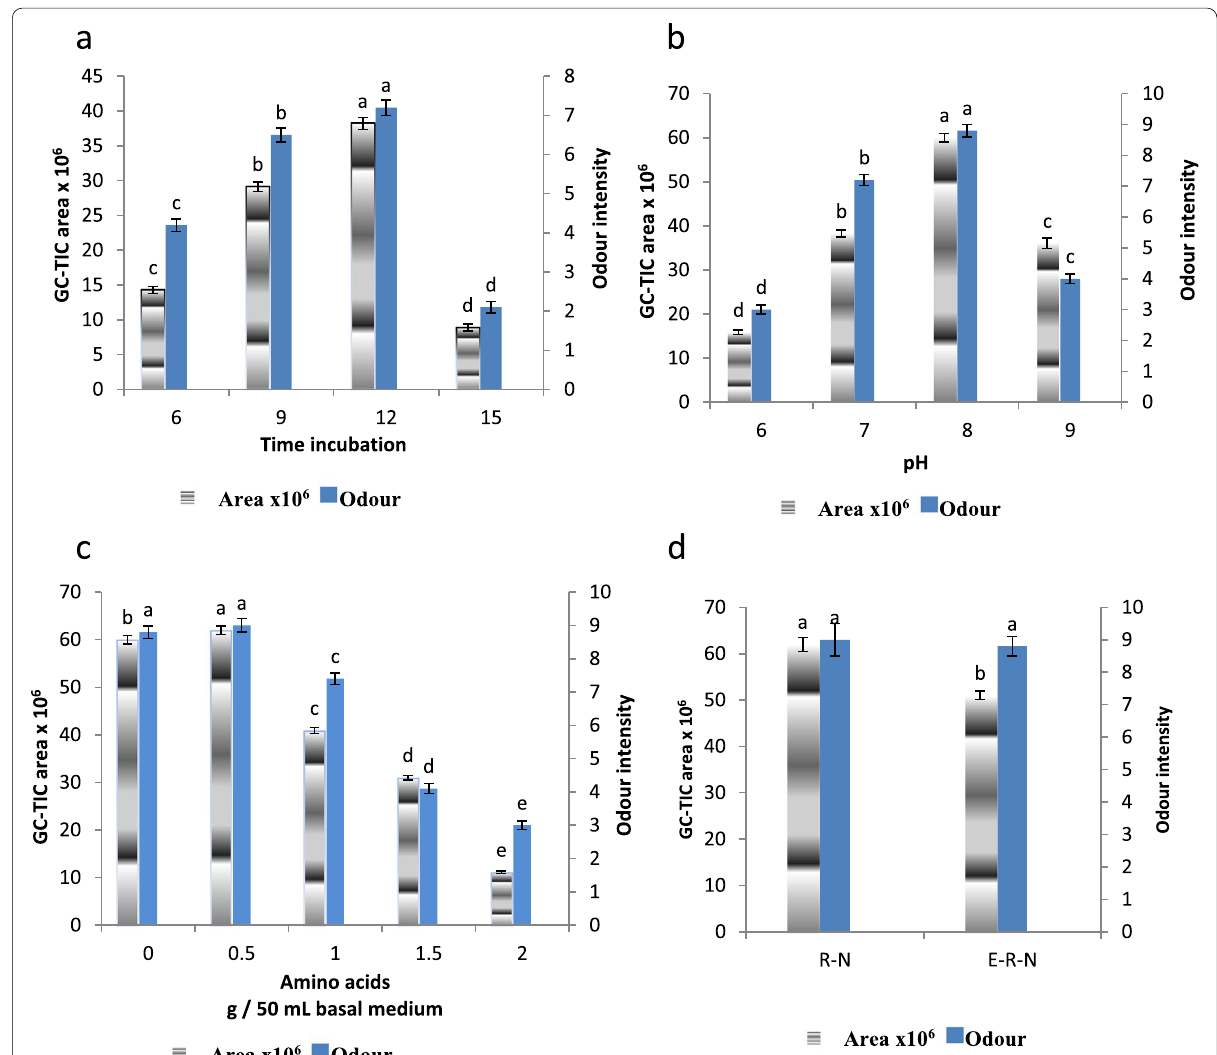
Fig. 3 Effect of incubation times ( a ), pH values ( b ), enrichment with amino acids ( c ) and encapsulation ( d ) on total content and odour intensity of the biogenerated volatiles. R-N: Roasted-nutty flavour; E-R-N: Encapsulated roasted-nutty